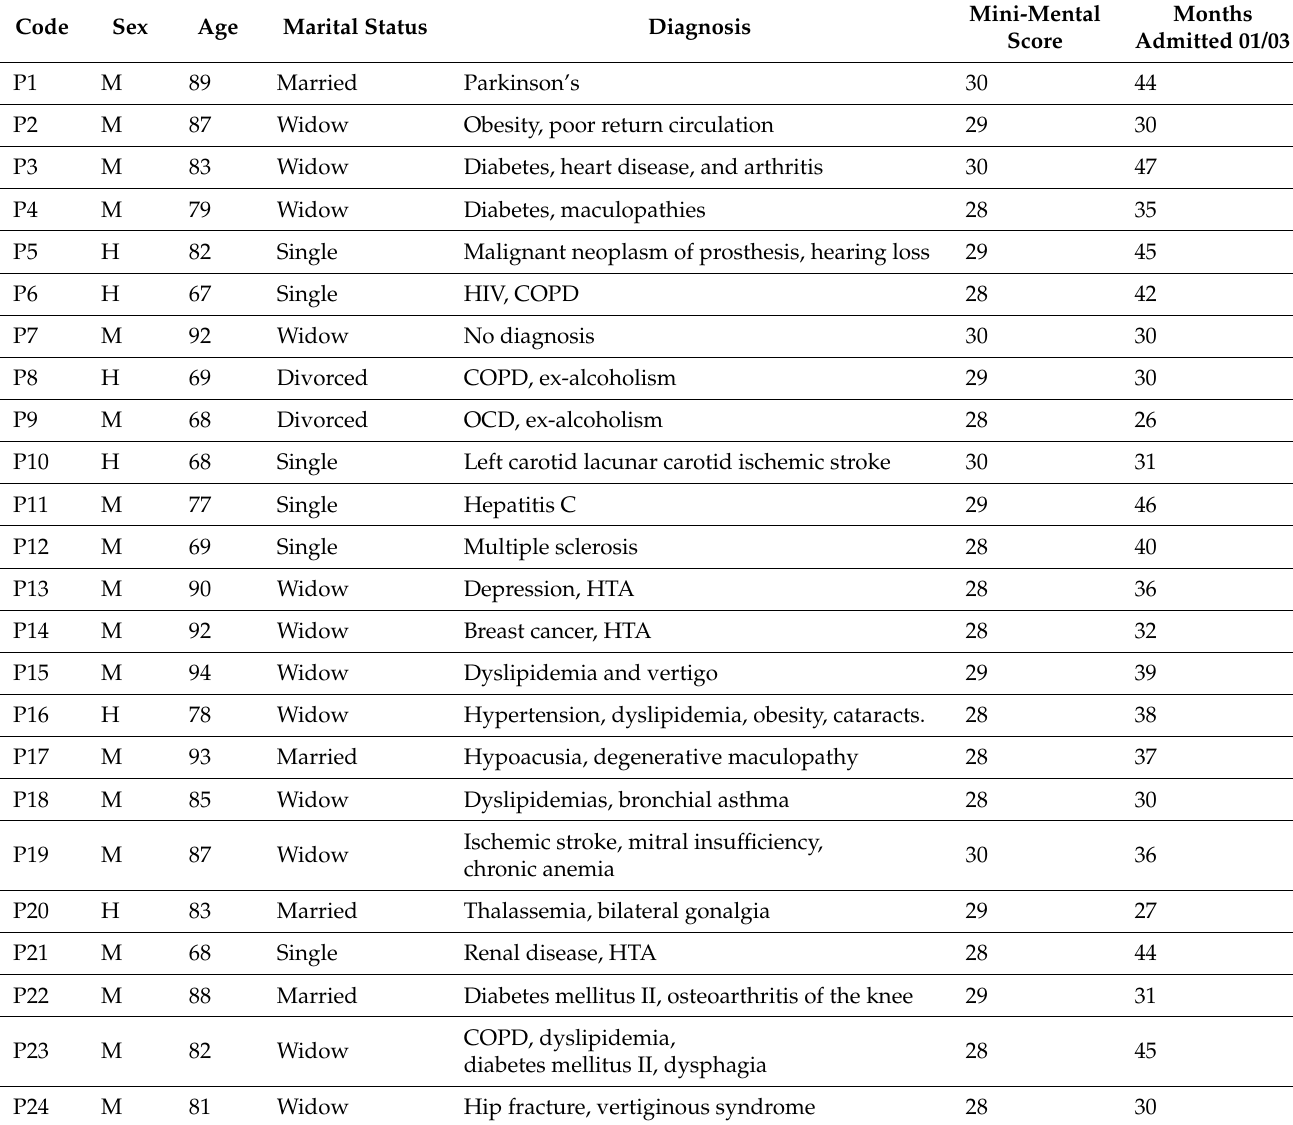
Table 2. Summary of clinical and sociodemographic